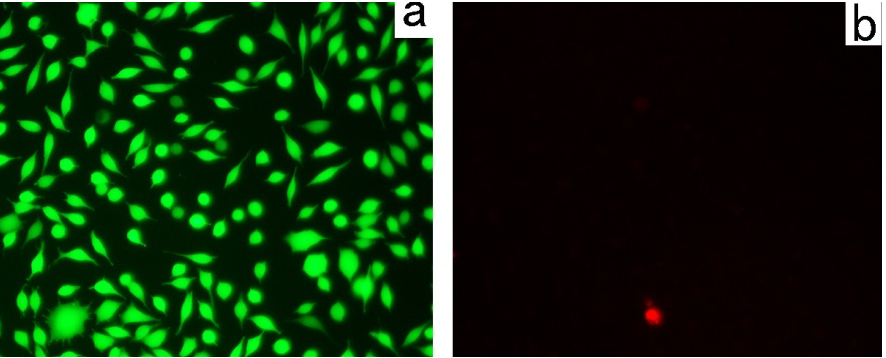
Figure 9. Human fibroblasts L929 in control well stained by live and death assay: ( a ) confocal images of L929; ( b ) dead cells in control well.